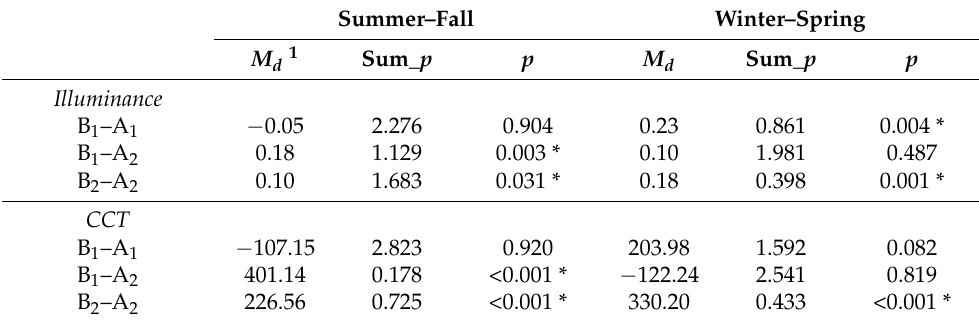
Table 7. Results of the separate randomization tests apart for fall–winter and